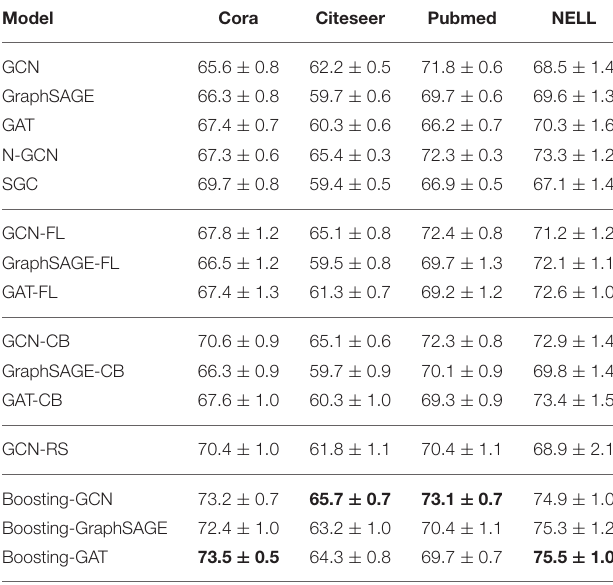
TABLE 2 | Summary of results in terms of classification accuracy (in percentage).